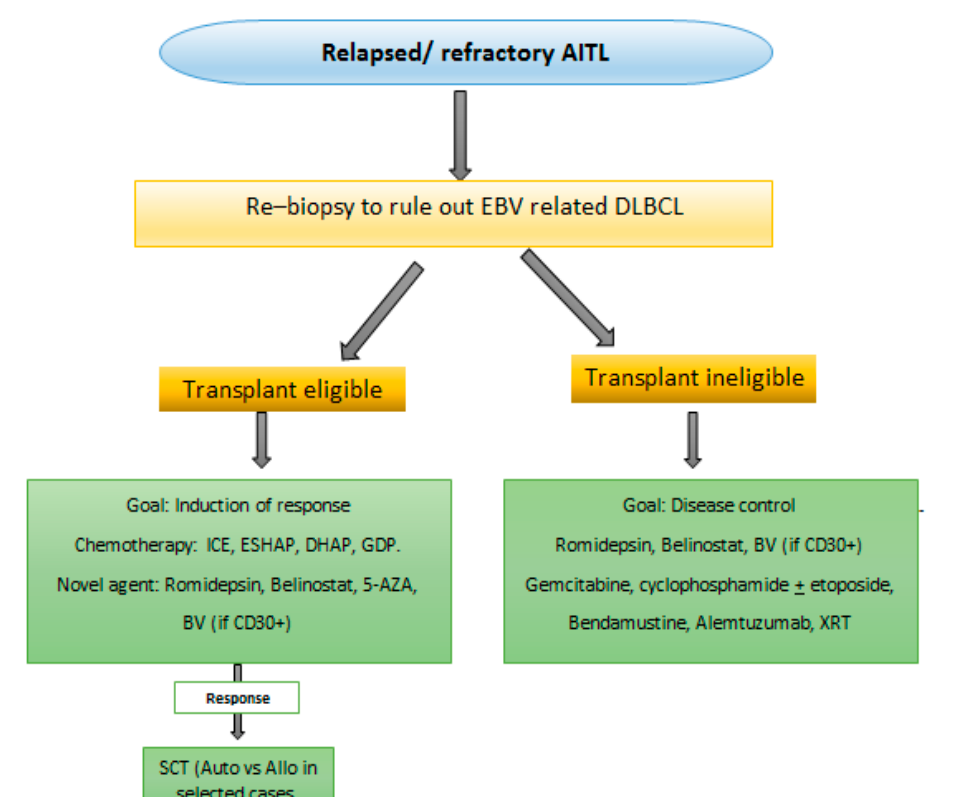
Figure 2. Suggested algorithm for relapsed/refractory AITL. Abbreviations: AITL, angioimmunoblastic T cell lymphoma; DLBCL, diffuse large B cell lymphoma; EBV, Epstein barr virus; Allo SCT, allogeneic stem cell transplantation; Auto SCT, autologous stem cell transplantation XRT, radiation therapy.